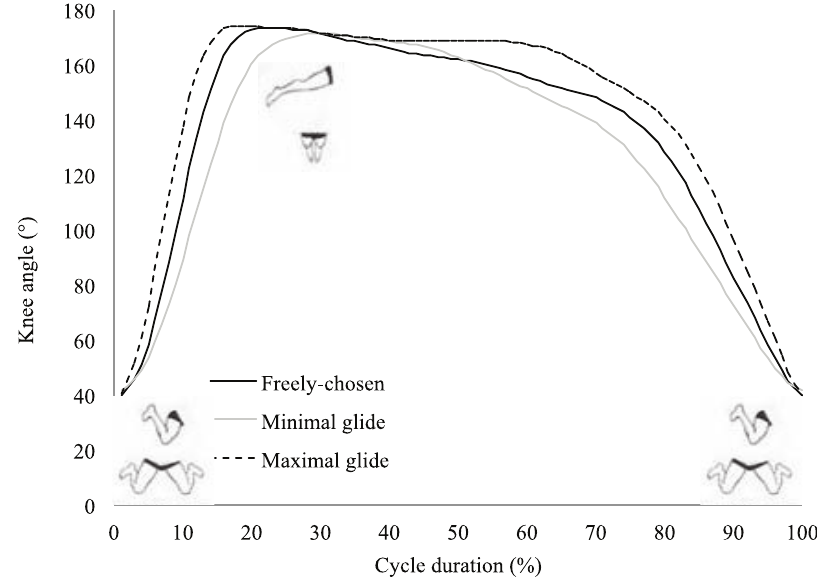
Figure 3. Knees angle (mean of six cycles from all participants) for the three coordination conditions. One stroke cycle corresponded to the period from one maximal knee flexion (0%) to the next maximal knee flexion (100%).